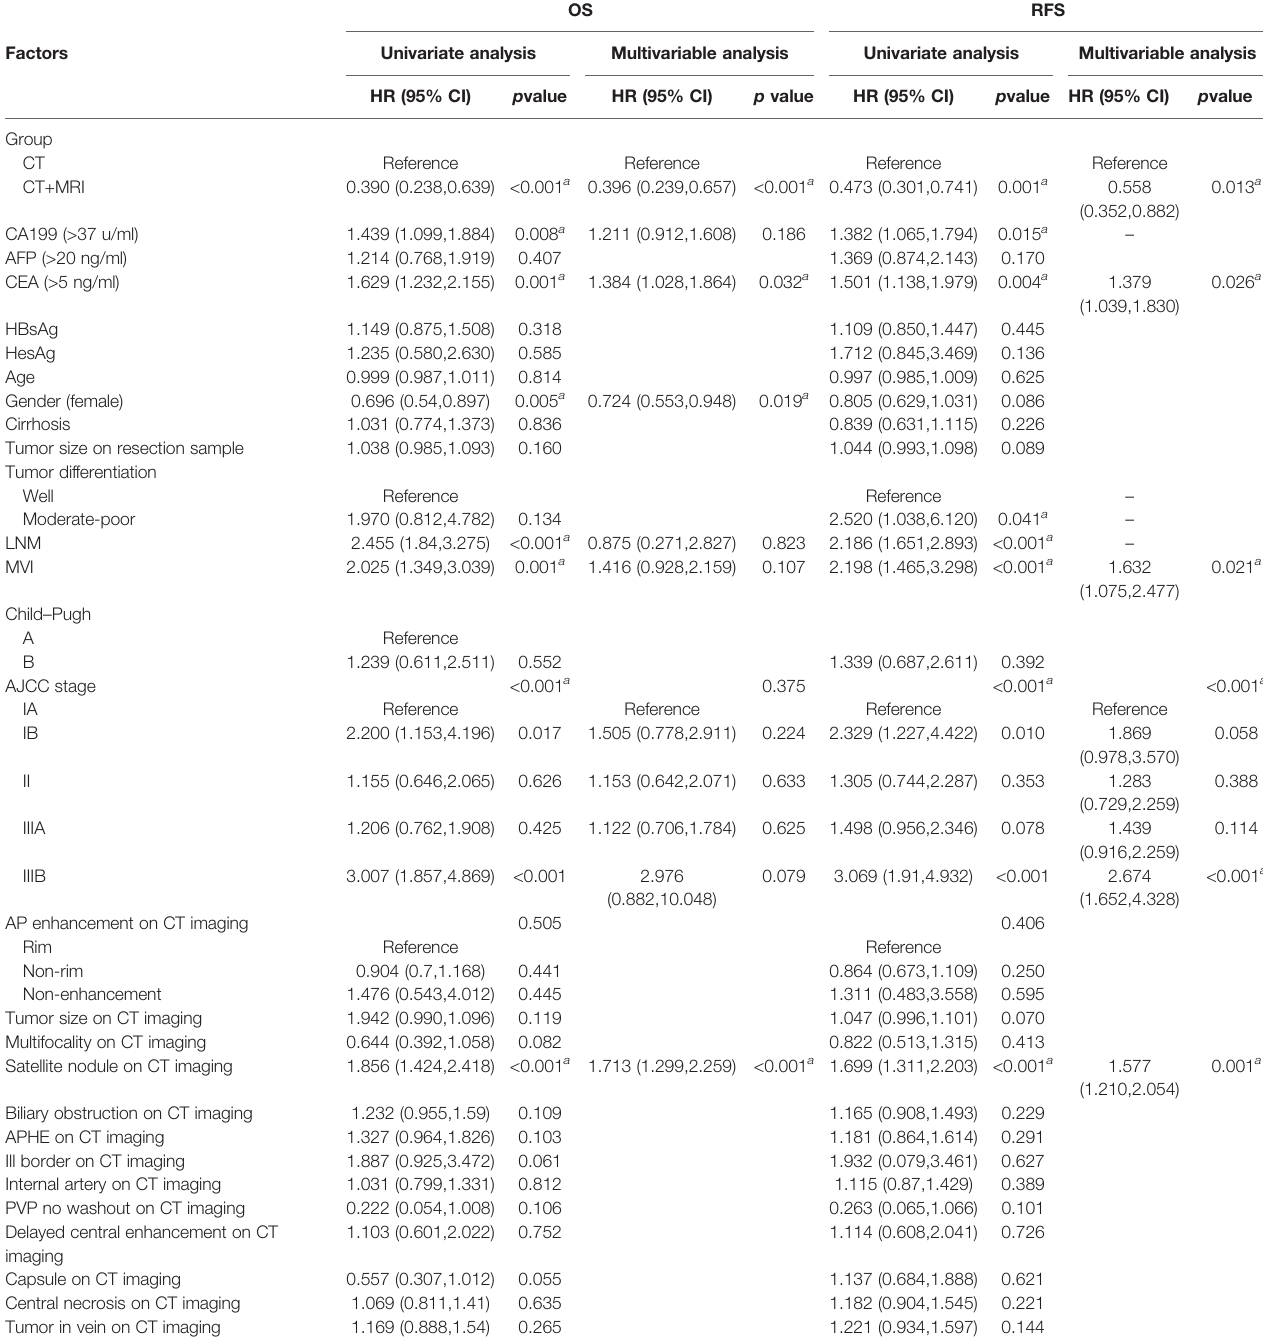
TABLE 4 | Cox regression analysis of OS and RFS for patients with